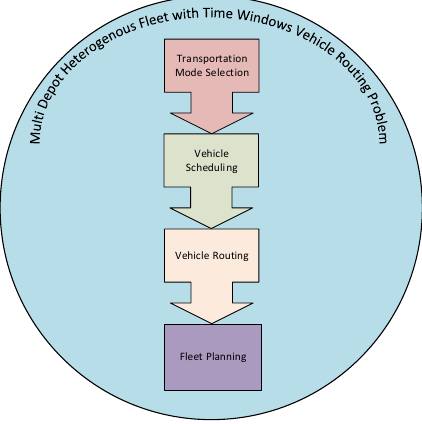
Fig. 1. Types of decision-making problems included in the model